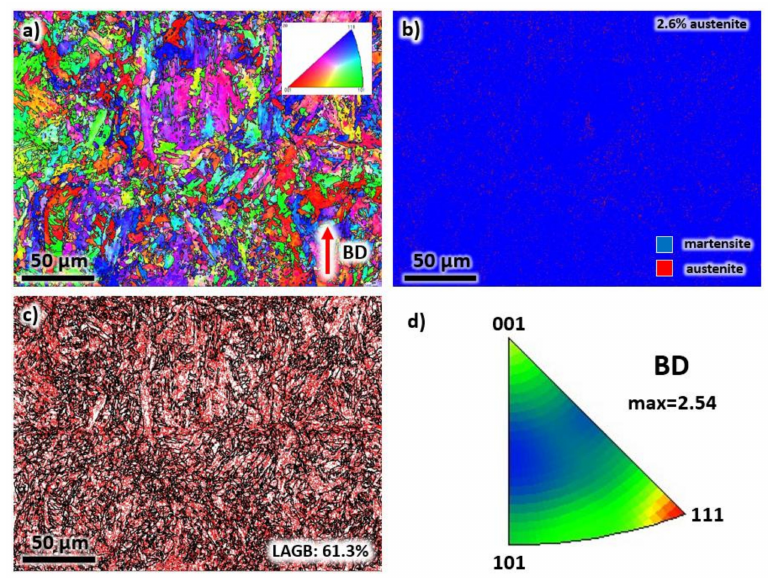
Figure 5. The ( a ) EBSD map, ( b ) phase map, ( c ) grain boundary map, and ( d ) IPF representation of each grain of the as-printed sample taken from the transverse direction.